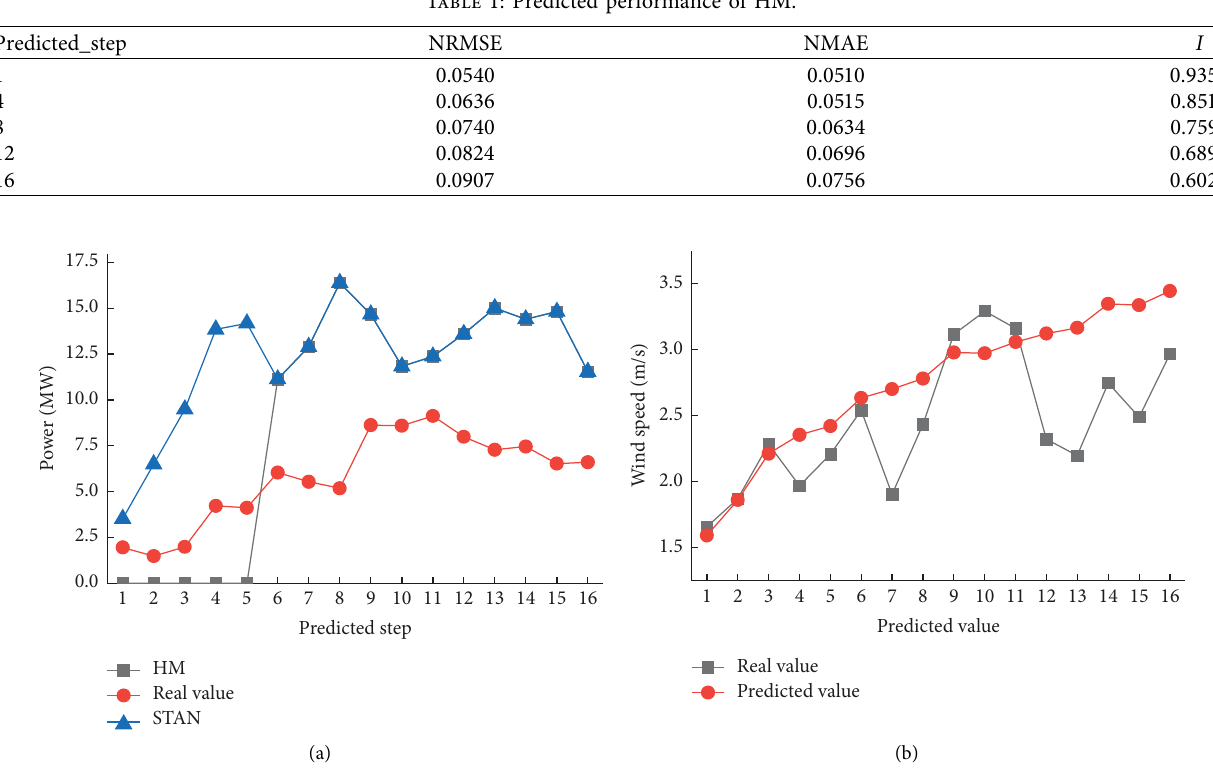
Figure 7: Applicability analysis of HM model for extremely low output scenarios: (a) power prediction curve and (b) wind speed correction